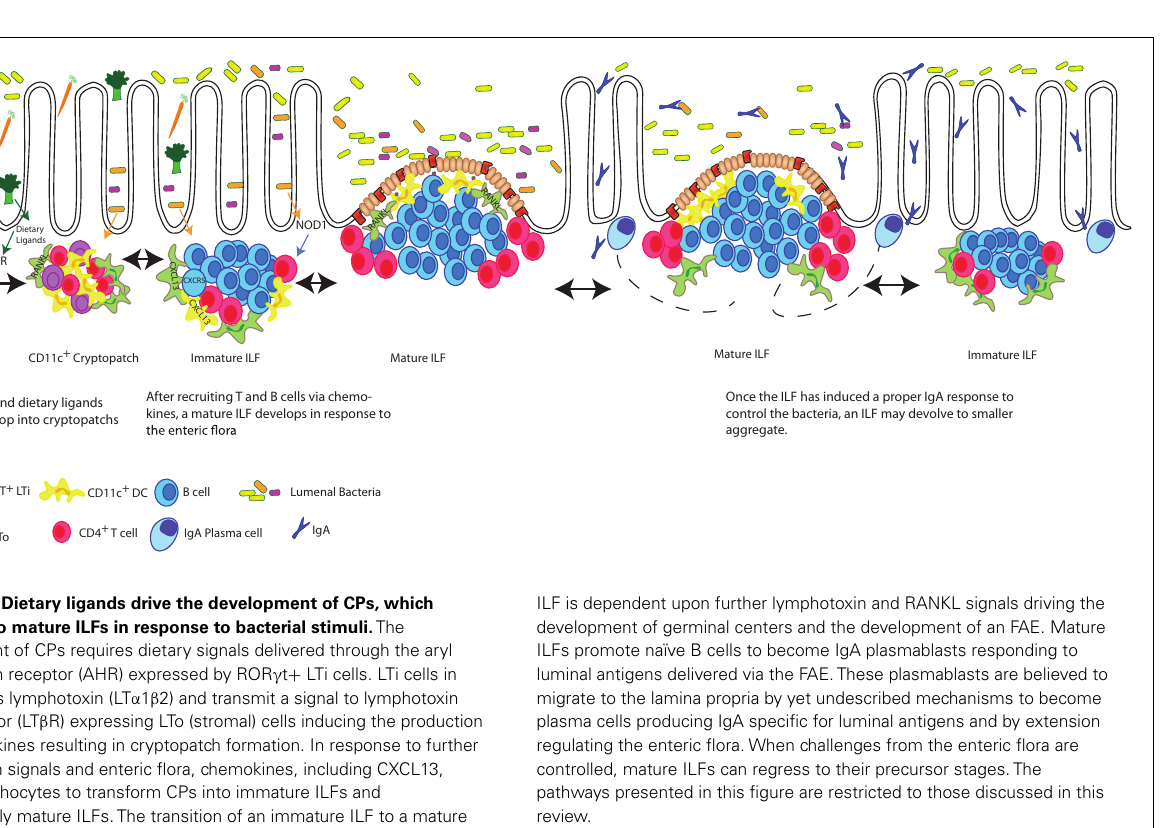
ILF is dependent upon further lymphotoxin and RANKL signals driving the development of germinal centers and the development of an FAE. Mature ILFs promote naïve B cells to become IgA plasmablasts responding to luminal antigens delivered via the FAE.These plasmablasts are believed to migrate to the lamina propria by yet undescribed mechanisms to become plasma cells producing IgA specific for luminal antigens and by extension regulating the enteric flora.When challenges from the enteric flora are controlled, mature ILFs can regress to their precursor stages.The pathways presented in this figure are restricted to those discussed in this